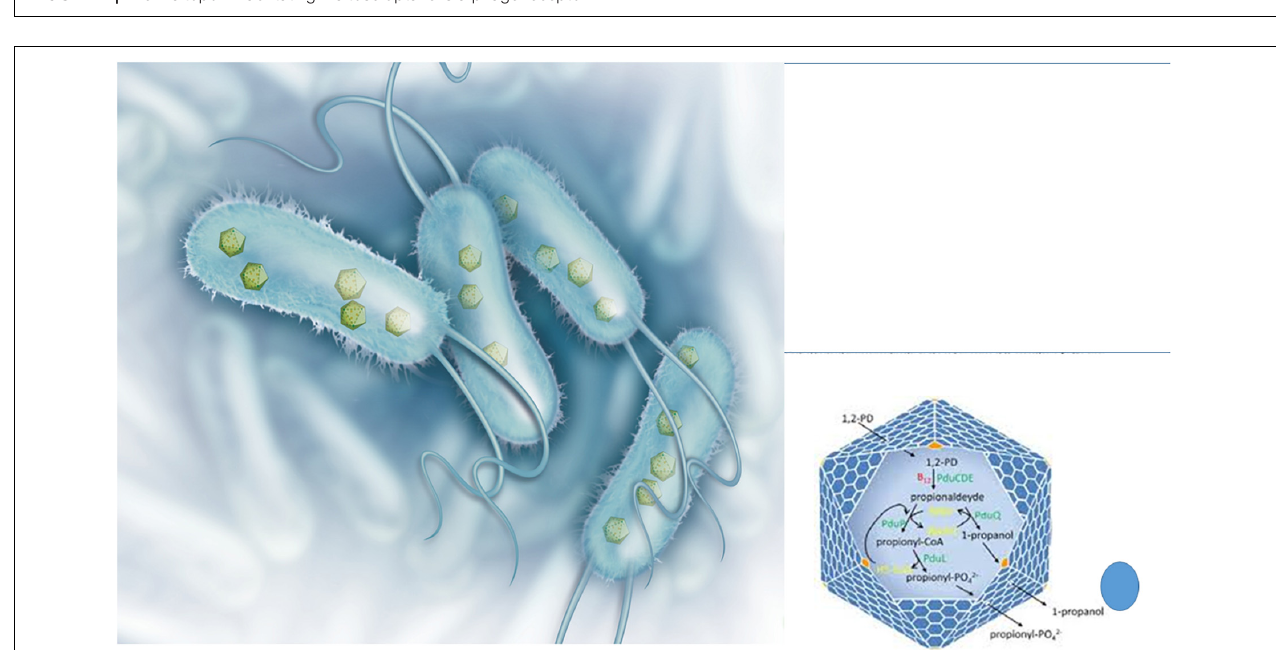
FIGURE 2 | The maltoporin facilitating maltose uptake is a phage receptor.